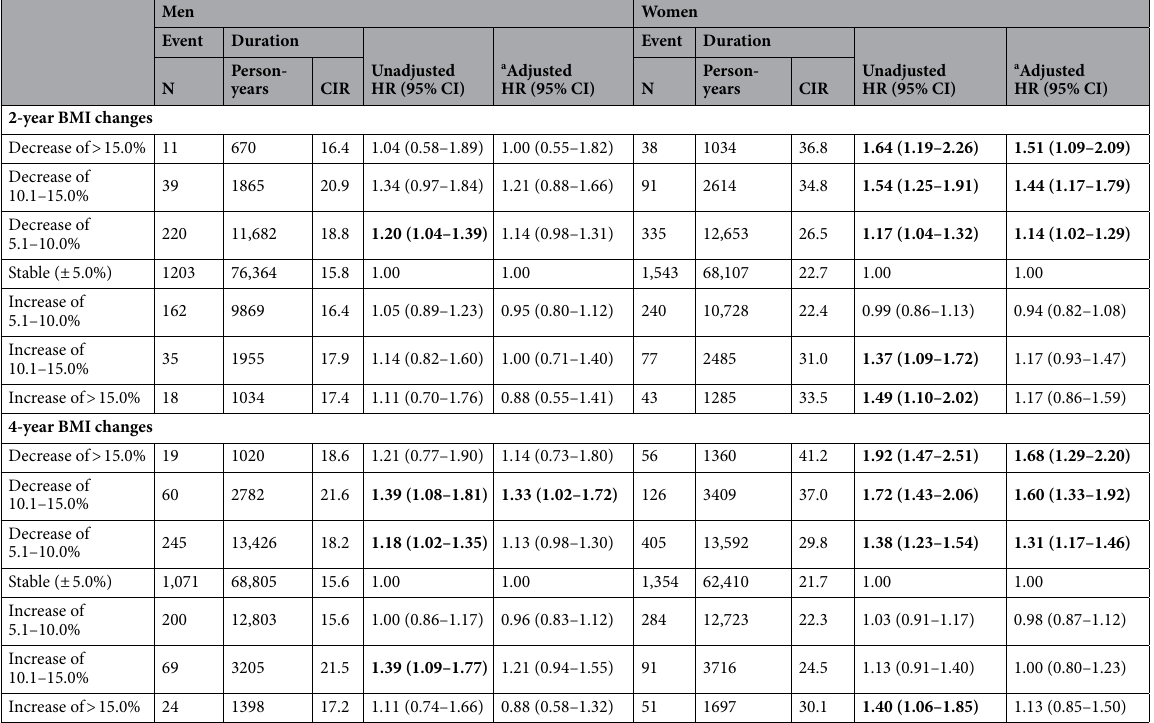
Table 2. Risk of Alzheimer’s disease according to BMI changes. BMI body mass index, CIR cumulative incidence rate, HR hazard ratio, CI confidence interval. a Adjusted for age, insurance premium, initial BMI, smoking status, alcohol consumption, regular exercise, hypertension, diabetes mellitus, and